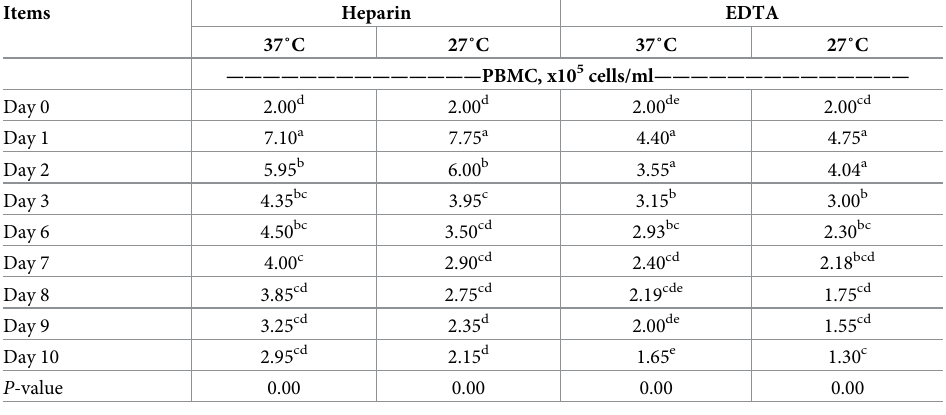
P -value 0.00 0.00 a,b,c,d,e Median values with different superscript letters within the same column were statistically significant (Friedman test, P <